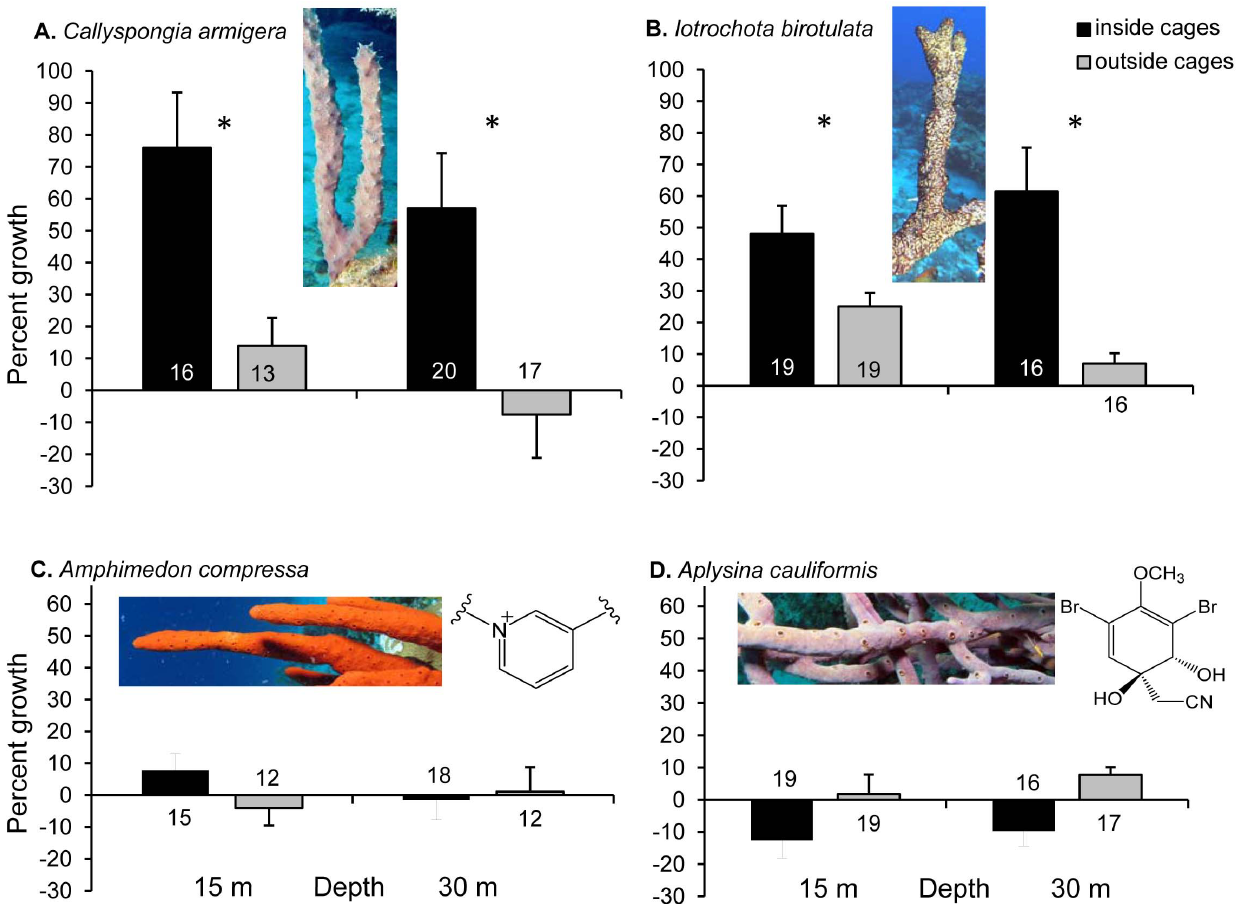
Figure 1. Percentage growth of branching sponge pieces (change in wet mass) 287 days after attachment inside and outside of predator-excluding cages at 15 and 30 m depth on Conch Reef, Florida. A: Callyspongia armigera and B: Iotrochota birotulata lack chemical defenses, while C: Amphimedon compressa and D: Aplysina cauliformis contain alkaloids that deter fish predators, represented by a portion of the chemical structure of amphitoxin for the former and aeroplysinin-1 for the latter. Surviving number of 20 replicates is shown for each bar, error bars are standard error. Statistical analyses were performed on transformed data (growth index). An asterisk indicates a significant difference in growth inside vs. outside cages ( p , 0.01).